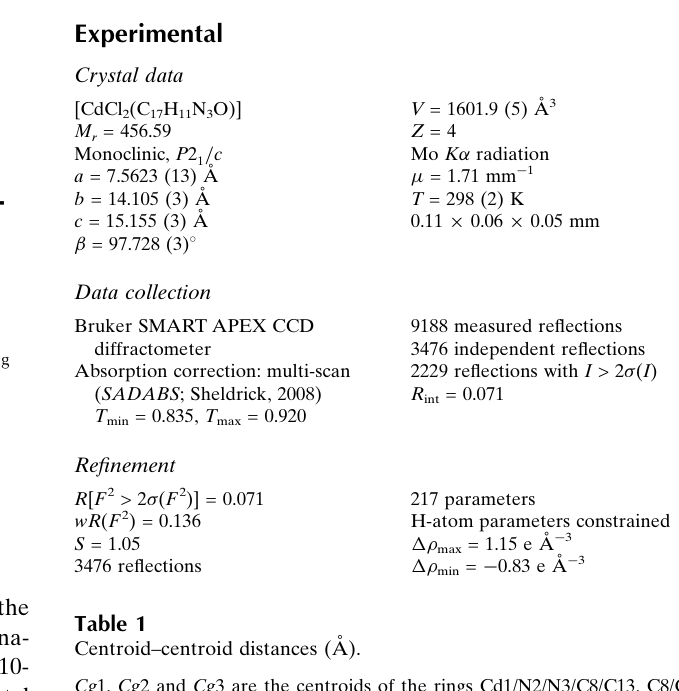
Centroid–centroid distances (A˚